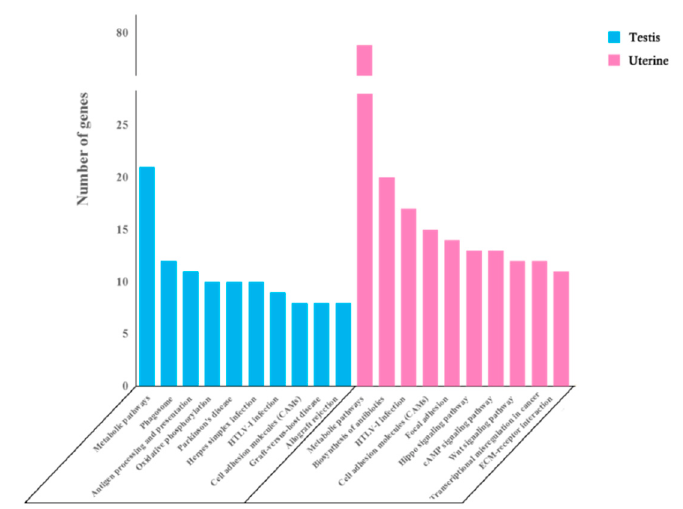
Figure 6. The most enriched pathways of DEGs in testis and uterine during infection. The clustered column shows the top 10 enriched pathways of DEGs from male mice testis and the other 10 of DEGs from the uterus of female mice.